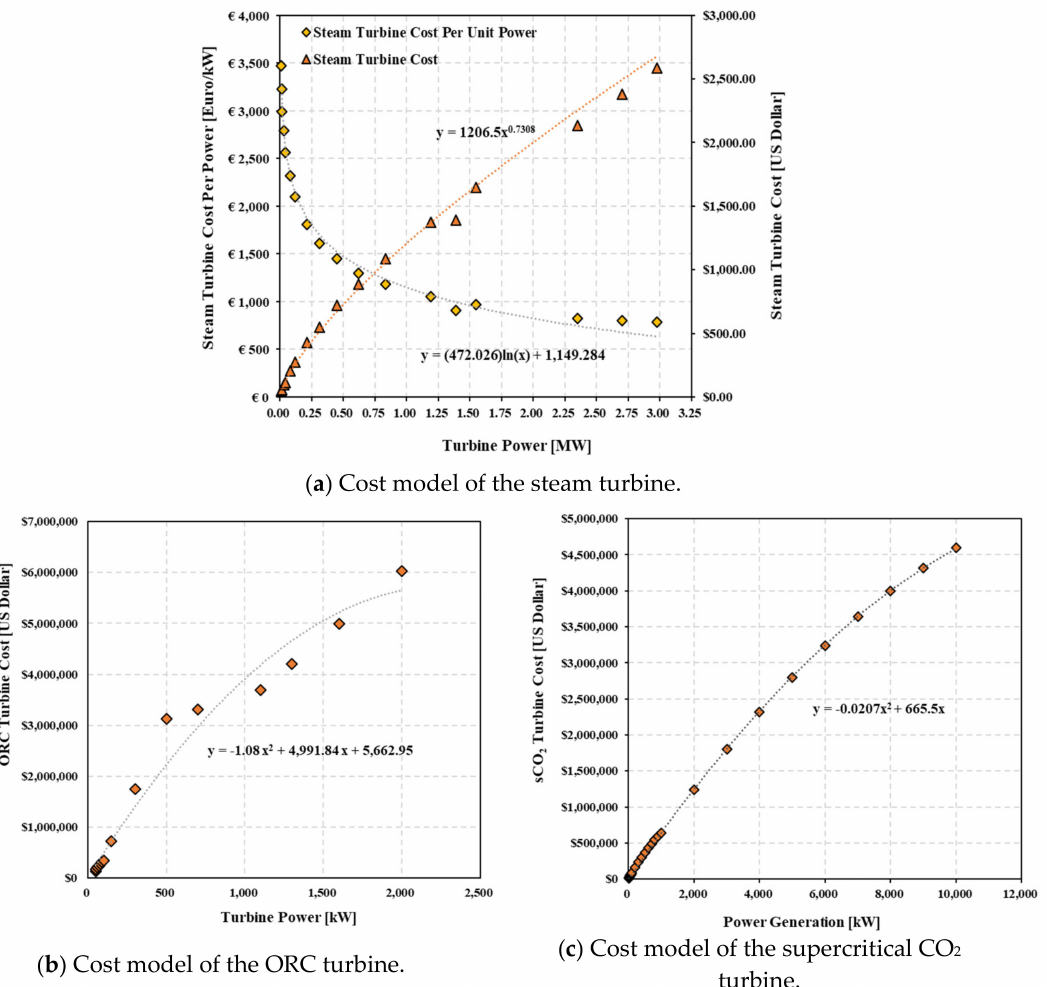
Figure 2. Turbine cost